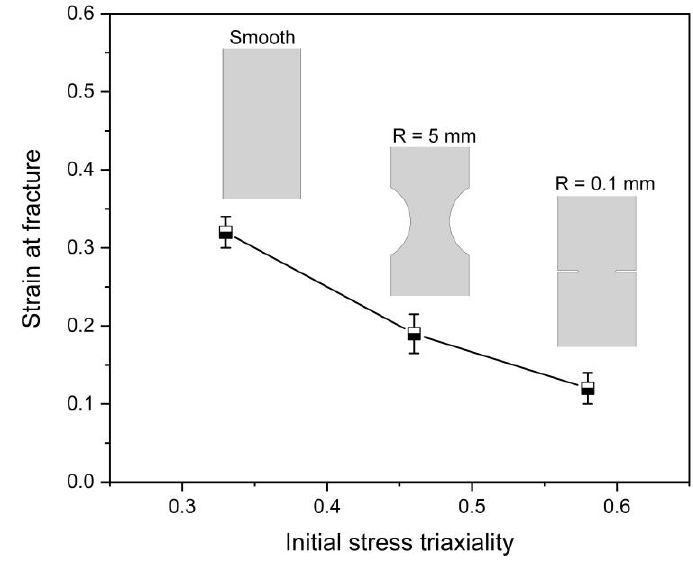
Figure 16. Strain at fracture sensitivity to the sample geometry.